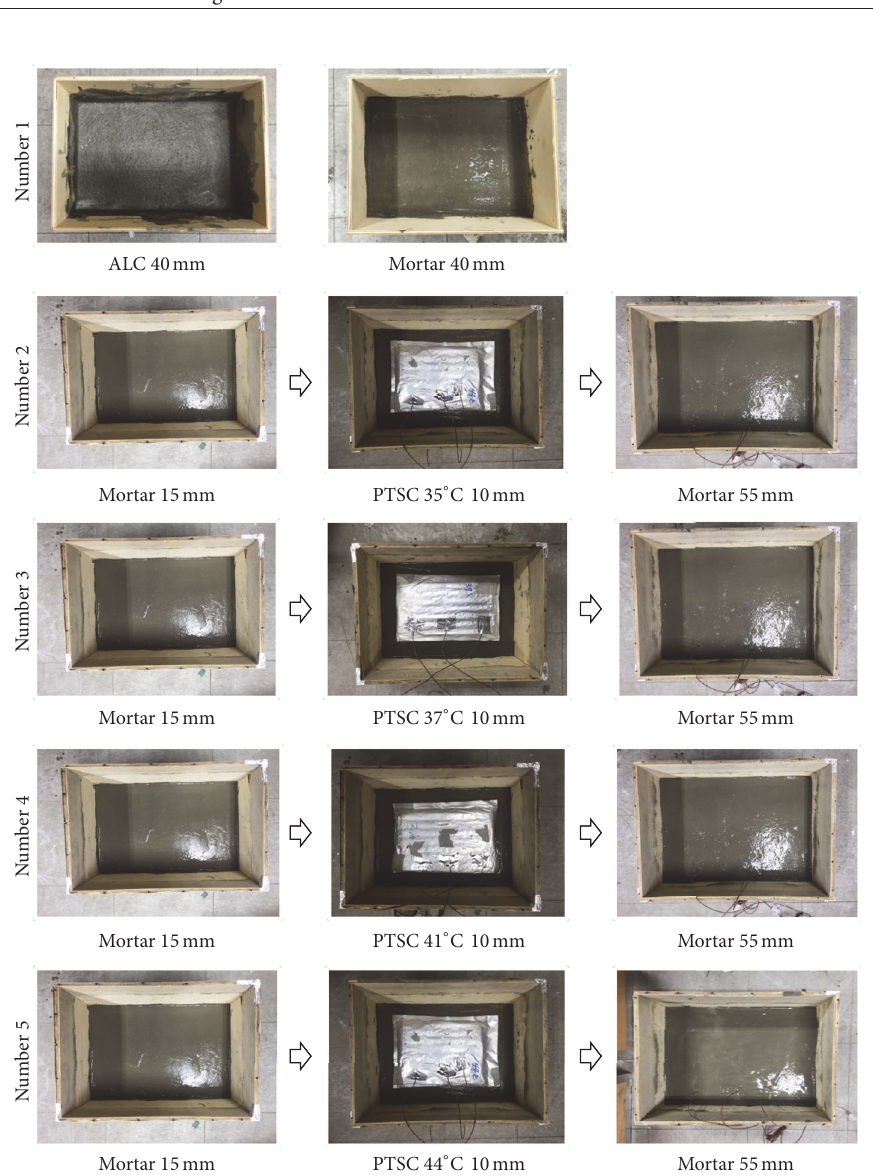
Figure 5: Fabrication process of experimental modules for existing and PCM underfloor heating